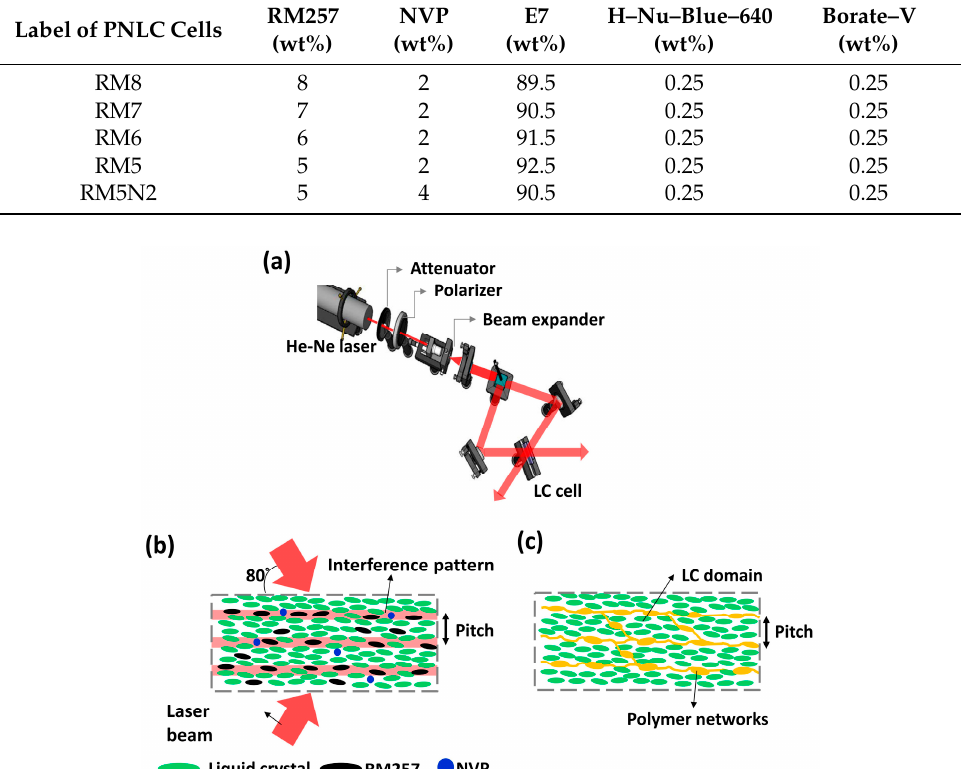
Figure 1 . ( a ) Experimental setup for processing holographic exposure; ( b ) Schematic illustration of holographic interference patterns generated in cell to expose the materials of RM257 and NVP to be photopolymerized; ( c ) Schematic illustration of holographic polymer networks formed in the cell after holographic exposure processes.